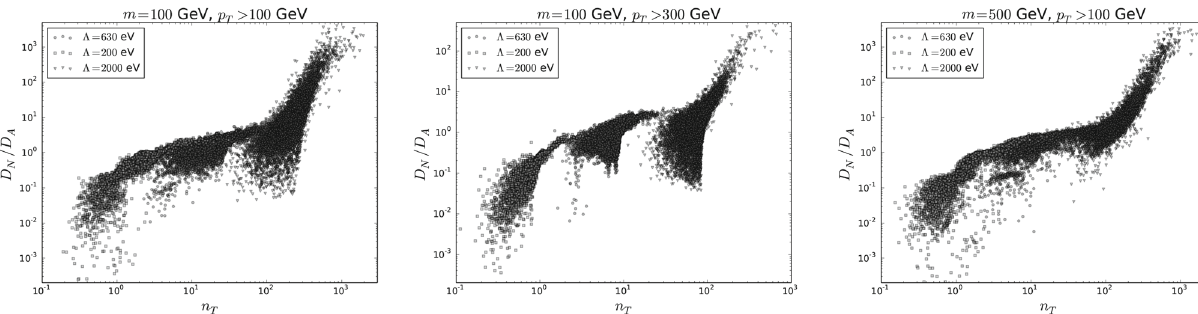
Fig. 8 The ratio between the quirk pair plane thickness obtained from numerical simulation ( D N ) and that calculated from Eq. 5.6 ( D A ), with respect to the quirk trajectory period ( n T ) inside the tracker